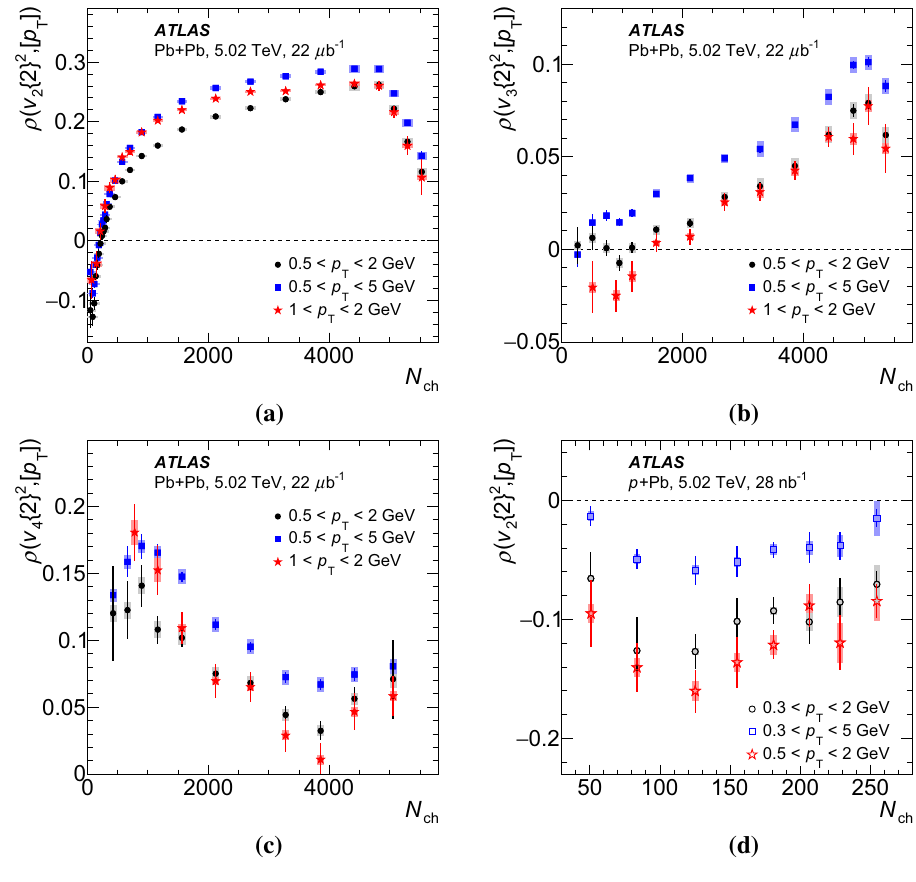
Fig. 5 The PCC ρ(v { 2 } 2 , [ p ] )) for n = 2 − n T